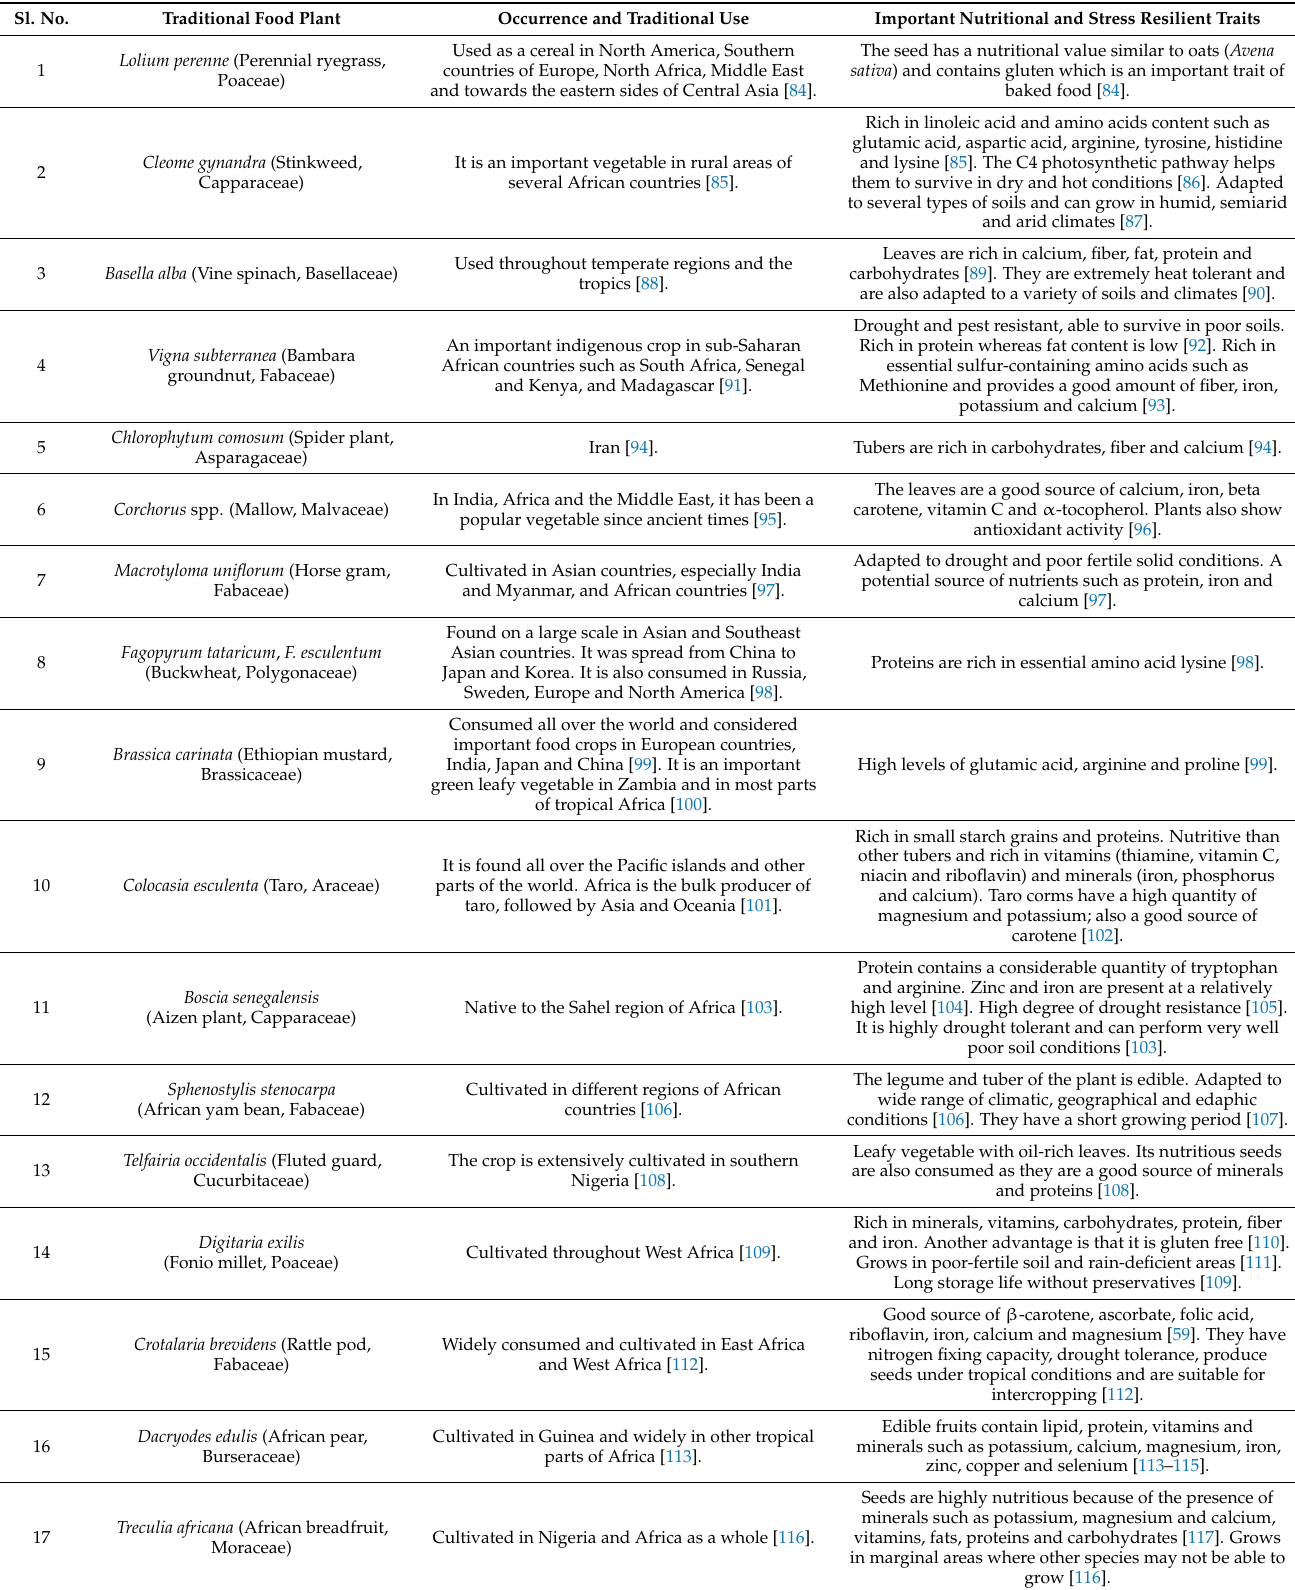
Table 1. Diverse traditional food plants grown across the globe, their uses and nutritional